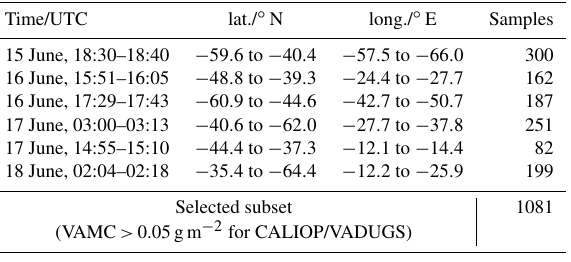
Figure 9. VAMC and VATH of a Puyehue-Cordón Caulle volcanic ash cloud around 16 June 2011 17:30UTC as retrieved by CALIOP (blue) and VADUGS (red); the upper uncertainty of the CALIOP- retrieved VAMC is shown in light-blue. Table 4. CALIOP measurements used for the statistical evaluation; all CALIPSO flyovers took place in June 2011.